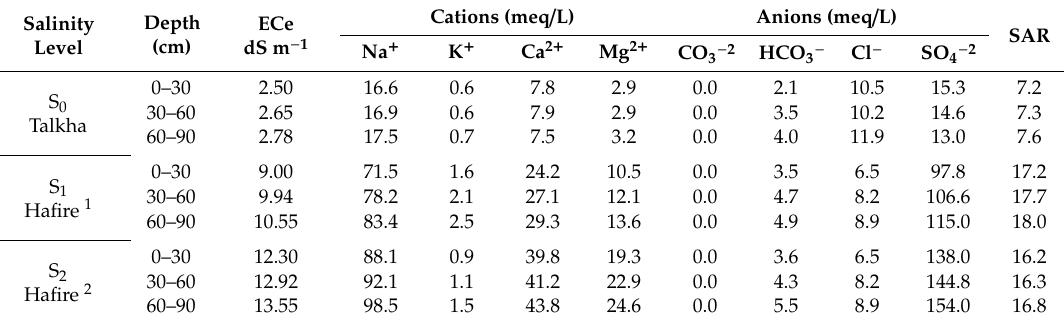
Table 1. Chemical analysis of soil in the experimental sites before cultivation. EC: electrical conductivity; SAR: sodium adsorption ratio.